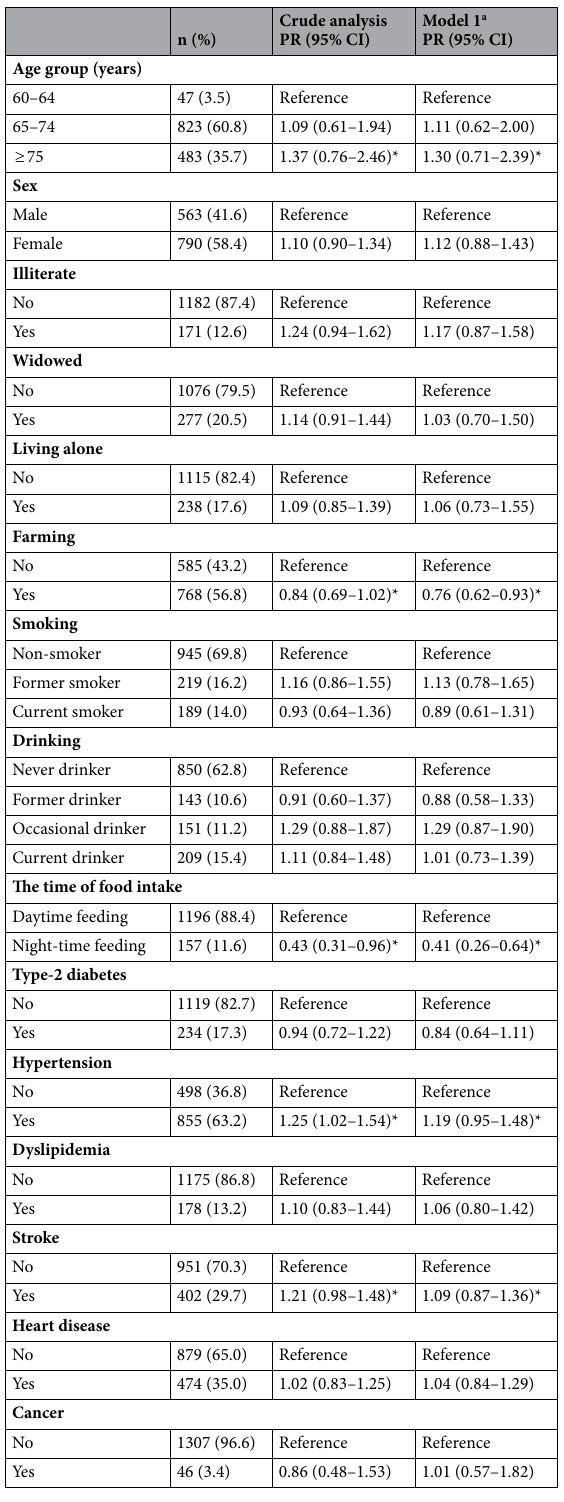
Table 3. Crude and adjusted analyses of the association between TRF (time feeding restricted to 10 h vs. no restriction) and demographic, psychosocial and behavioral factors. Poisson regression, TRF is the dependent variable. TRF Time restricted feeding, PR prevalence ratio, CI confidence interval. a Model 1 is adjusted for age, sex, BMI, IADL, illiterate, widowed, living alone, farming, smoking, drinking, the time of food intake, IPAQ, type-2 diabetes, hypertension, dyslipidemia, stroke, heart disease, and cancer. Likelihood ratio test, all P < 0.001; *P <